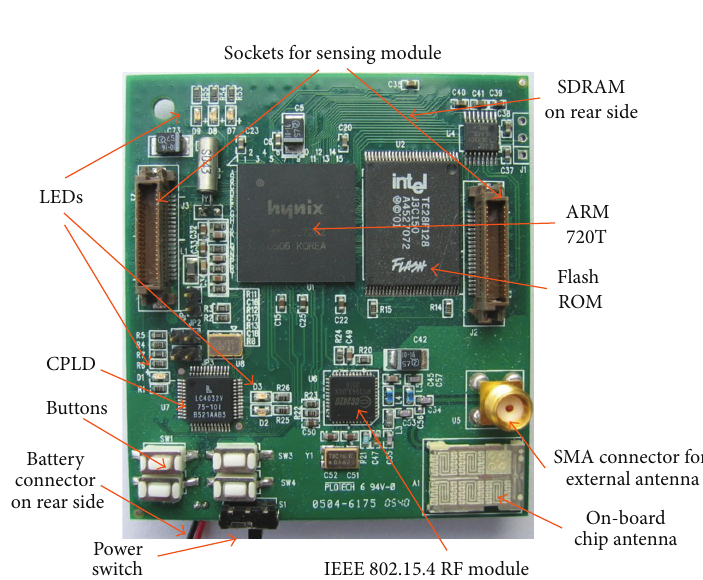
Figure 1: The ZigBee over IEEE 802.15.4 protocol stack.